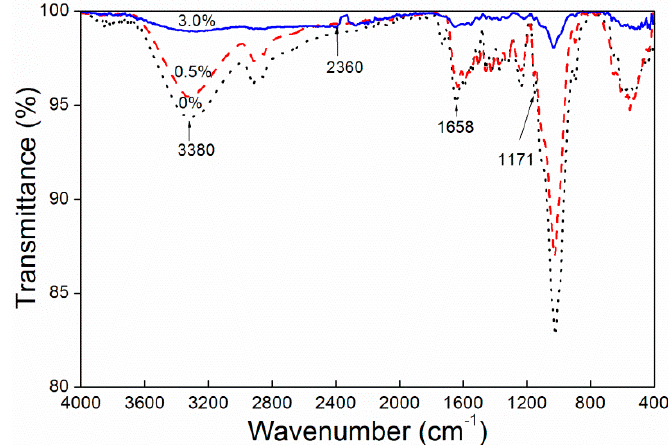
Figure 4. IR spectra of F. mandshurica veneer after dyeing with different concentrations of reactive red. Table 5. Assignment of peaks.